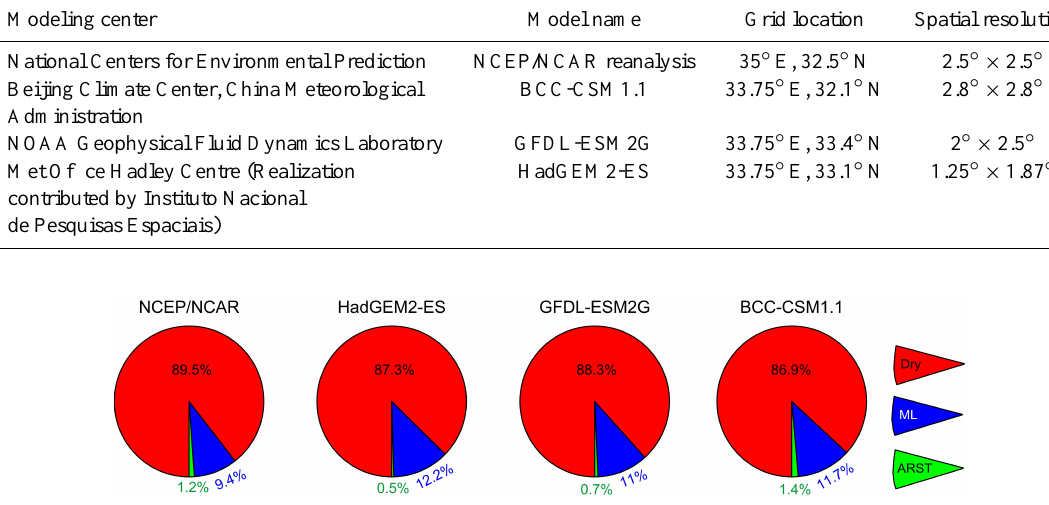
Table 2. Summary of the control (NCEP/NCAR reanalysis) and the climate models (CMIP5) used in the study.